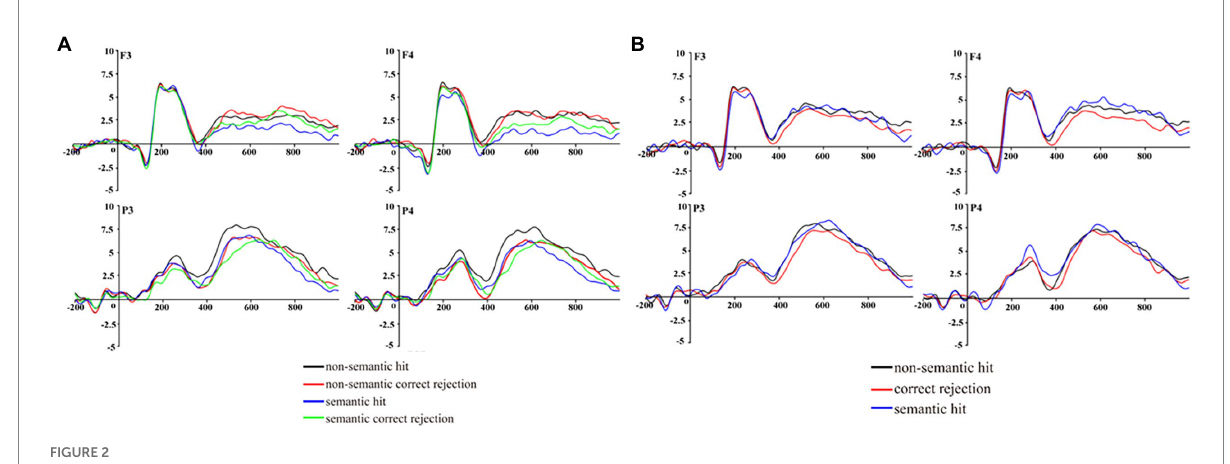
FIGURE 2 Grand averaged event-related potentials for Phase 2 (A) and Phase 3 (B)